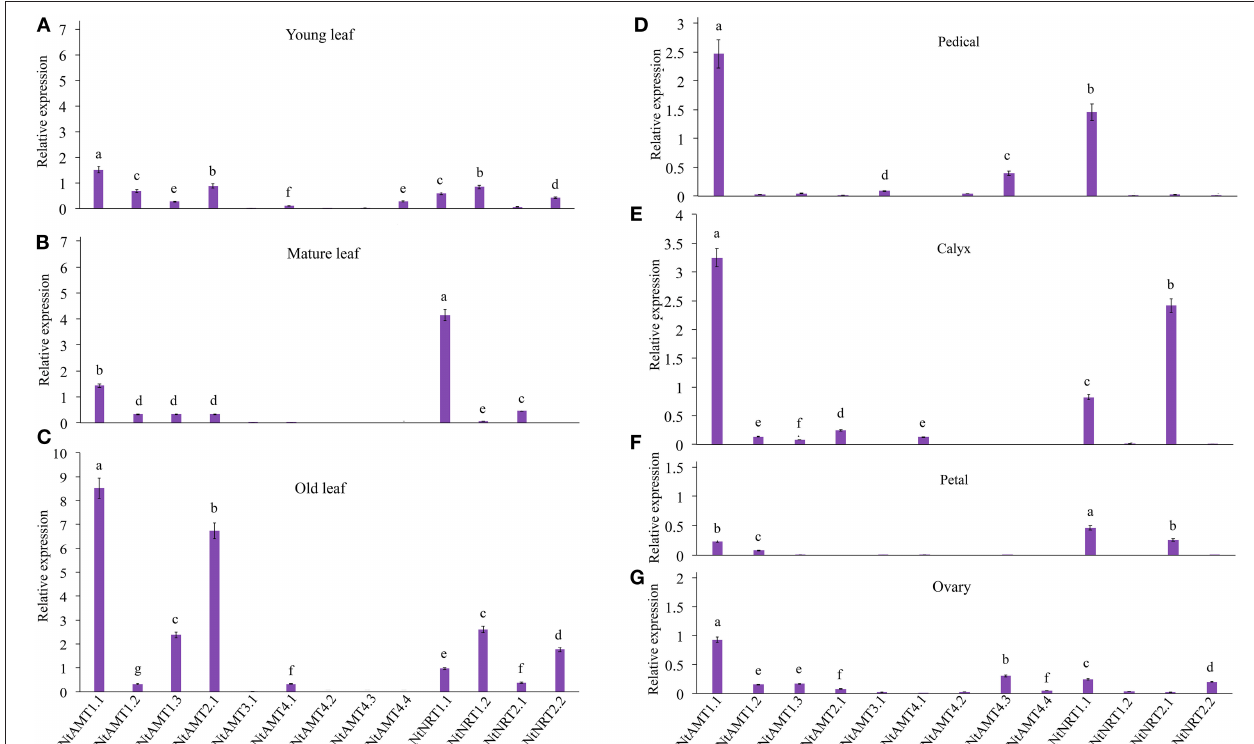
FIGURE 2 | Measurement of the gene expression of AMTs and NRTs in different aged leaves and flower-tissues. Tobacco (K326) was grown in pot-soil for 3 months until flowering (see section Materials and Methods). Relative mRNA accumulation of AMTs and NRTs was assayed by using qPCR (see section Materials and Methods), which was performed with total RNA isolated from petals, calyxes, pedicels, ovaries, young leaves (the 3th leaf counted down from the top first-full-expended leaf), mature leaves (the 10th leaf) and old leaf (the 18th leaf), respectively. Gene-specific primers for a given AMT or NRT were used throughout this study (see Table S3). Before performing qPCR, the correctness of resulting amplicons of target genes was confirmed by DNA sequencing (note: this test was done throughout expression studies). Relative expression levels of AMTs and NRTs relative to that of tobacco α -tubulin (set to 1; Schmidt and Delaney, 2010) were calculated. Means of 3–4 biological replicates ± SD ( n = 3–4) were plotted, and different letters above the bars indicate statistically significant differences ( P < 0.05 by one-way ANOVA and a multiple comparison test). A second housekeeping gene L25 was also used as an internal control to confirm the expression pattern (Schmidt and Delaney, 2010) (Figures S2A,B). The relative expression of NtAMTs and NtNRTs in mature leaf (A) , young leaf (B) , old leaf (C) , petals (D) , calyxes (E) , pedicels (F) and ovaries (G) .